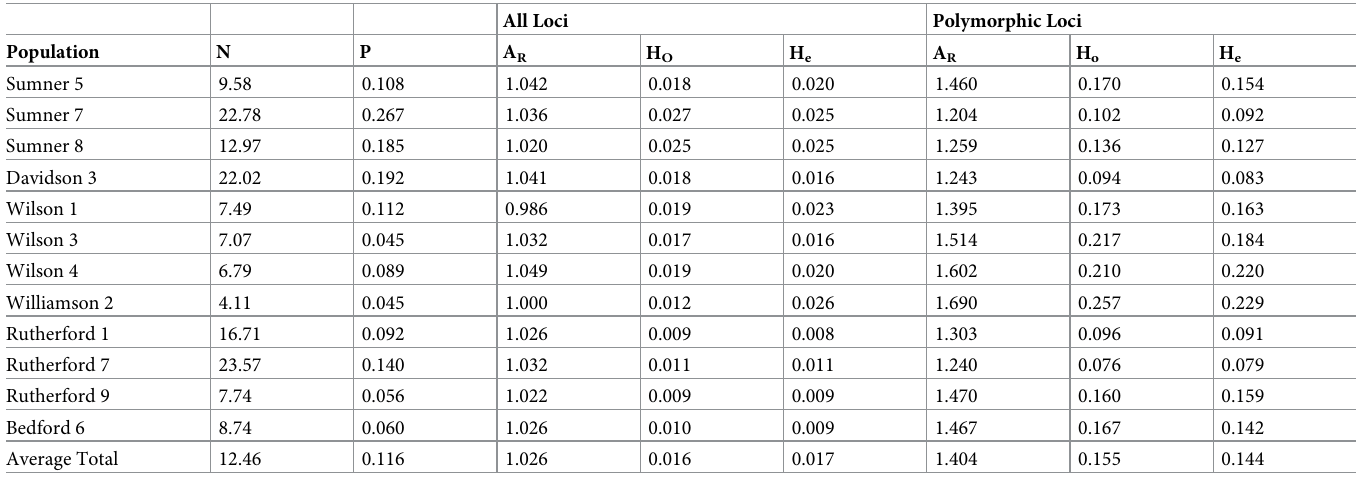
Table 3. Standard measures of genetic diversity for 12 populations of Ambystoma barbouri in Tennessee based 586 SNP loci. Summary statistics include the average number of individuals genotyped per locus ( N ) and the proportion of SNPs that were polymorphic within each population ( P ). Allelic richness (A R ), observed heterozygos- ity (H O ), and expected heterozygosity (H e ) were calculated for all loci and again for only those loci that were polymorphic within each population.